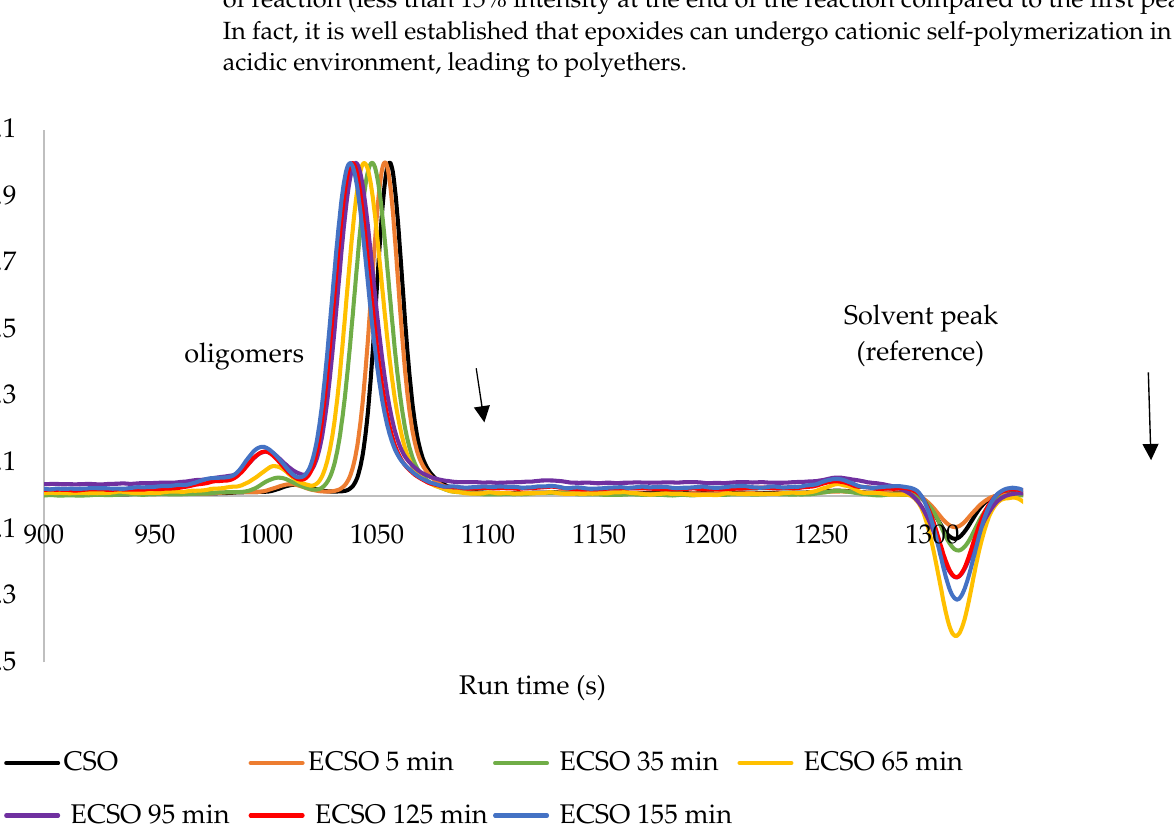
Figure 5. GPC chromatograms of CSO (cottonseed oil) and ECSO (epoxidized cottonseed oil) at different reaction times performed at 70 °C.